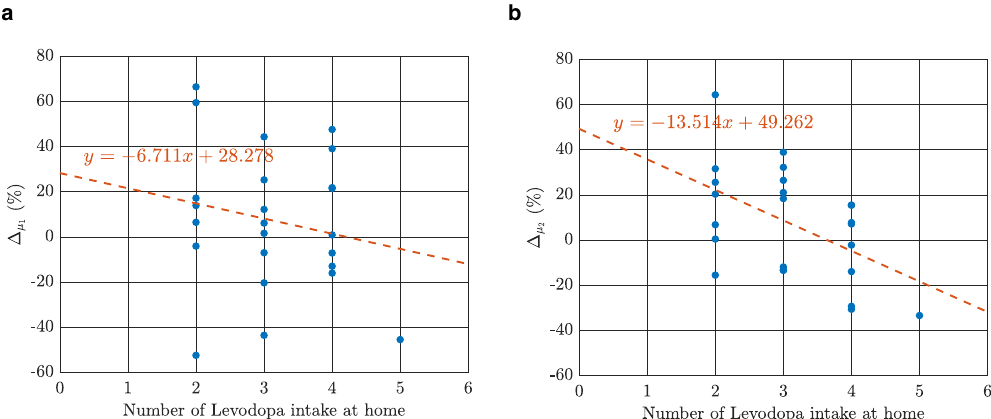
Fig. 5 The relationship between the number of medication doses taken during the interval of data recording in home assessment. This and ( b ) Δ μ linear relationship is shown for ( a ) Δ μ 1 2